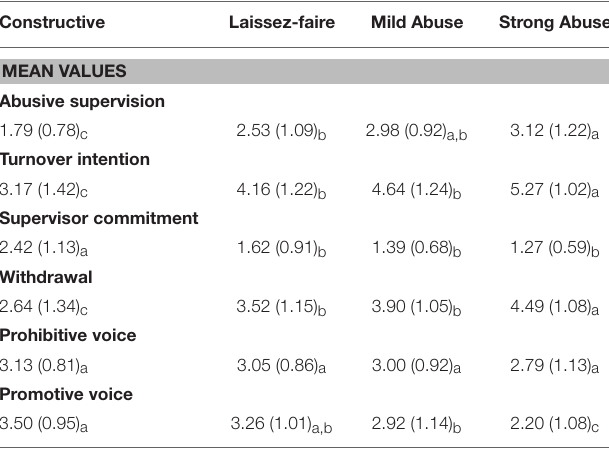
TABLE 4 | ANOVA results for the differences between the vignettes on perceptions and reactions (Study 2). Constructive